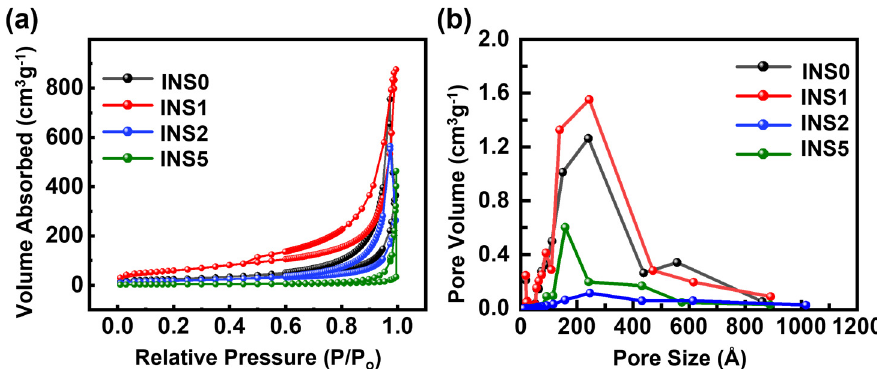
Figure 3. ( a ) Nitrogen adsorption/desorption isotherms. ( b ) Pore-size distribution curves.